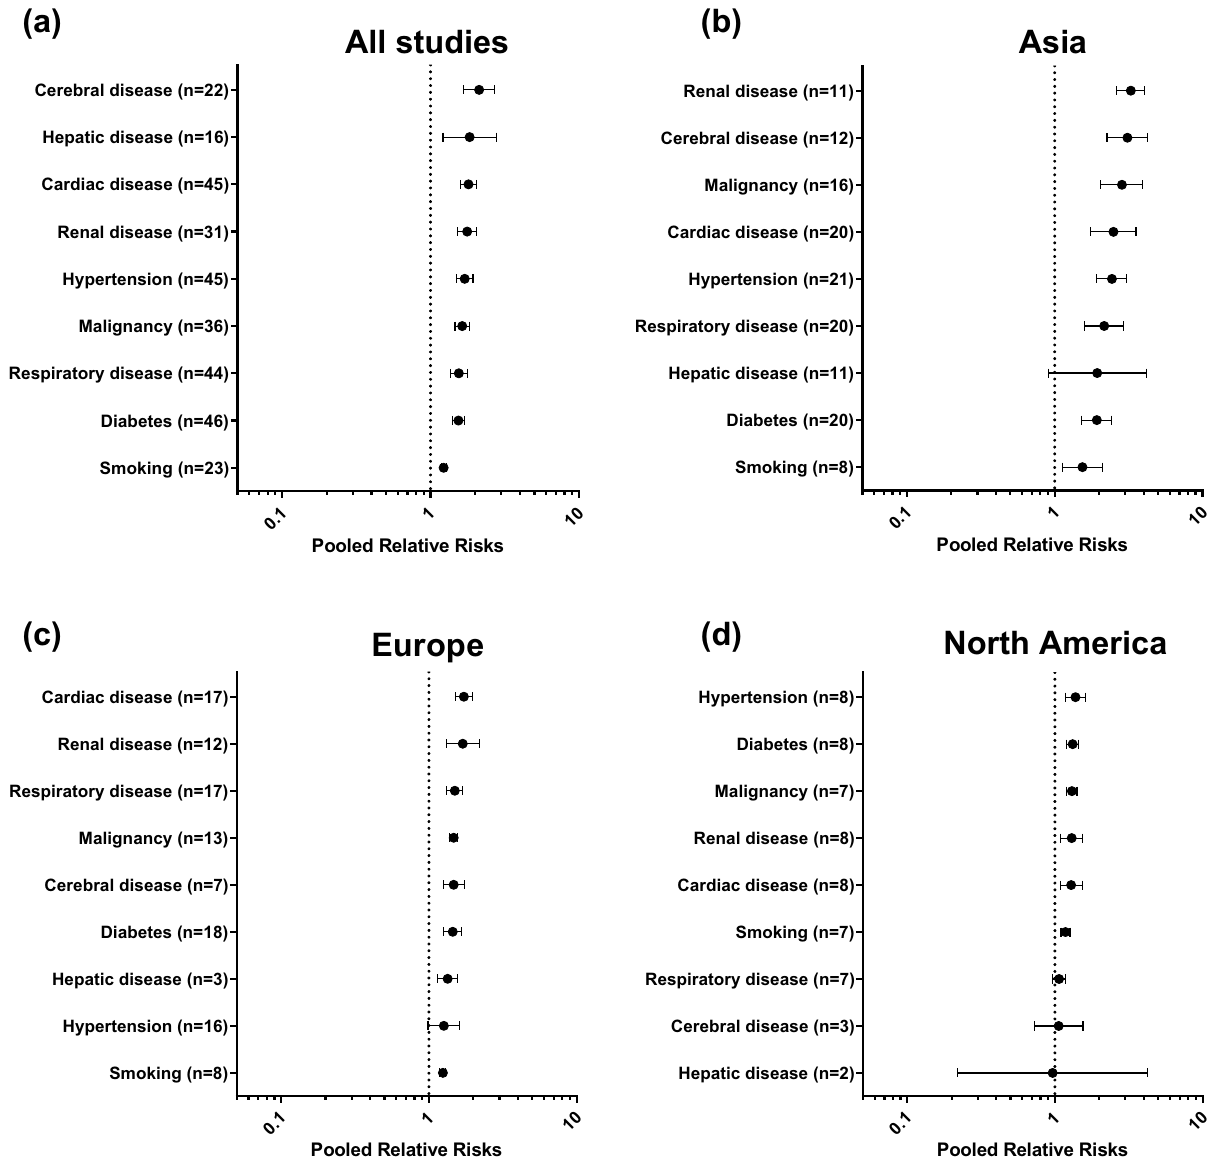
Figure 1. Impacts of underlying medical conditions on the critical outcome of COVID-19. The numbers in parenthesis represent the number of studies included in the pooled analysis. ( a ) Pooled analysis of all included studies. ( b )–( d ) Pooled analyses of studies performed in Asia, Europe, and North America,